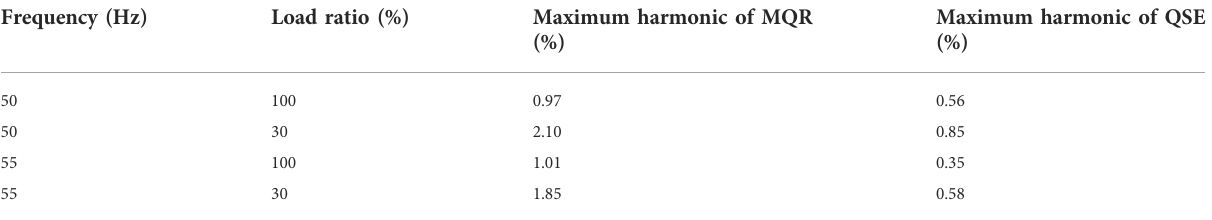
TABLE 2 Maximum of harmonic